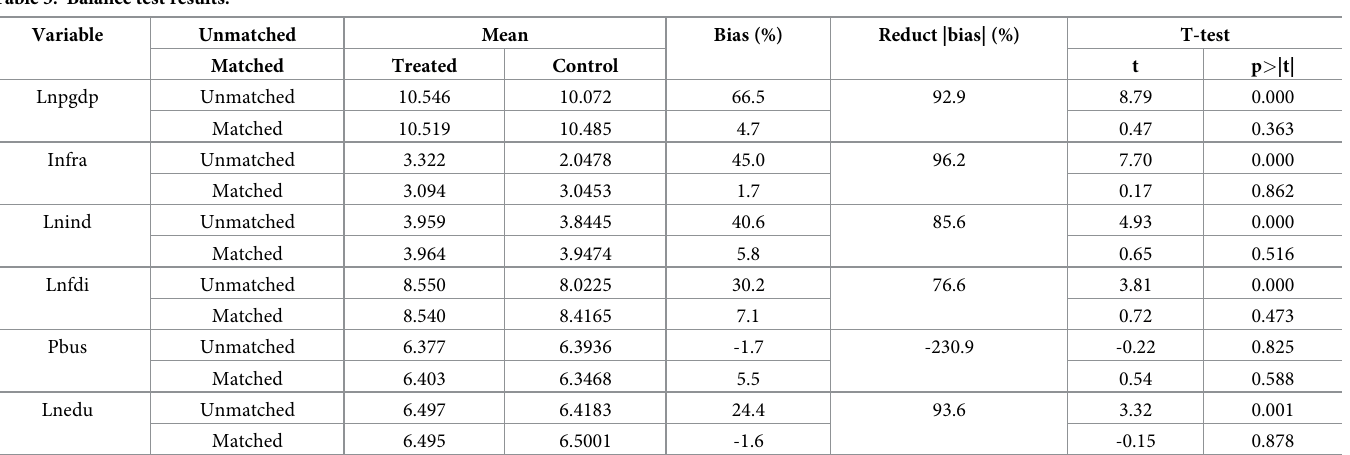
Table 5. Balance test results.